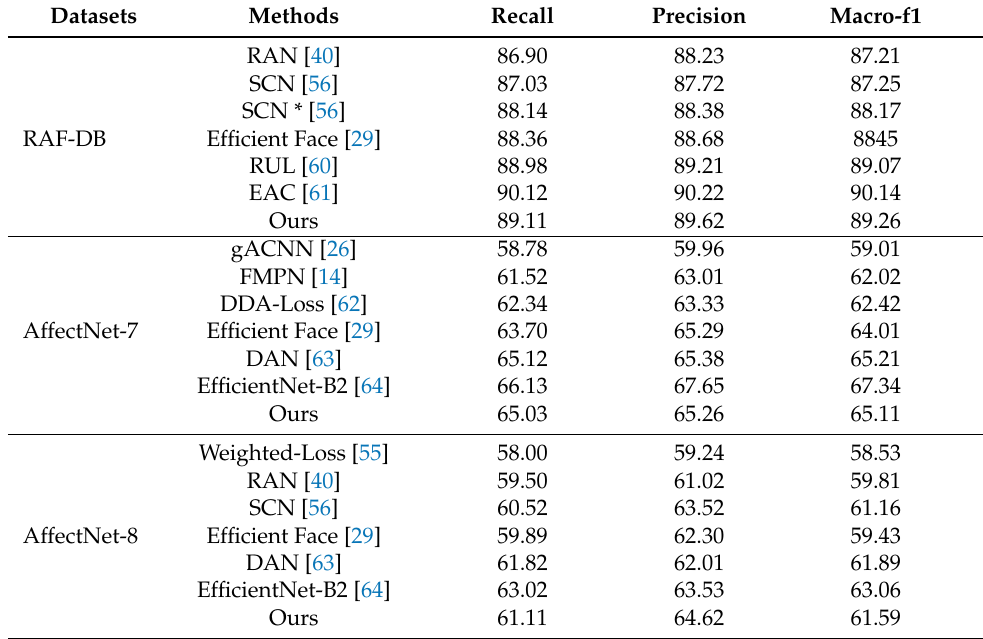
Table 4. Comparison with state-of-the-art methods on RAF-DB, AffectNet-7, and